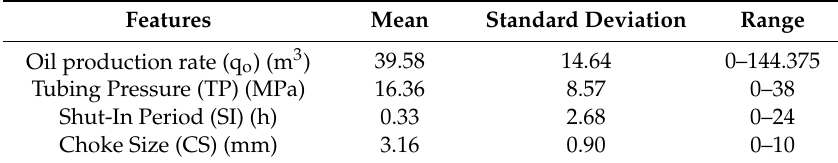
Figure 4. Heatmap of Pearson correlation coefficients of various variables.